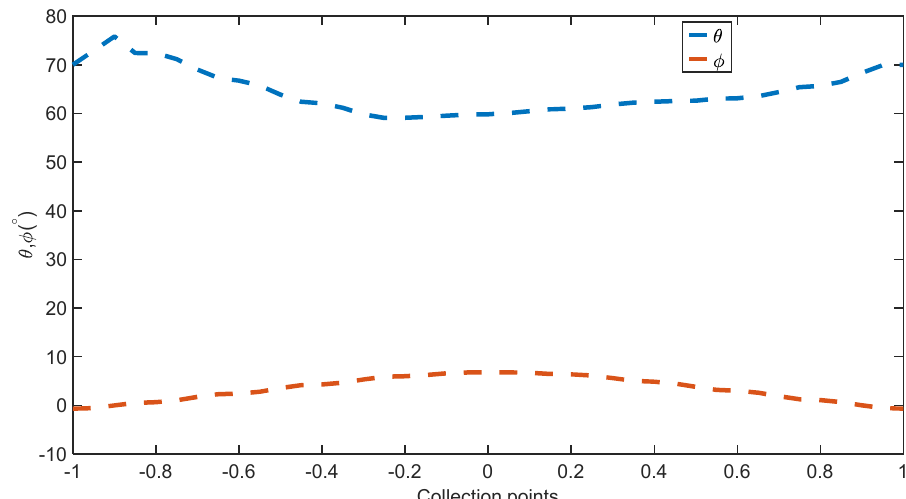
Figure 6. The LGR collection points of state variables (taking pitch and yaw angle as examples).